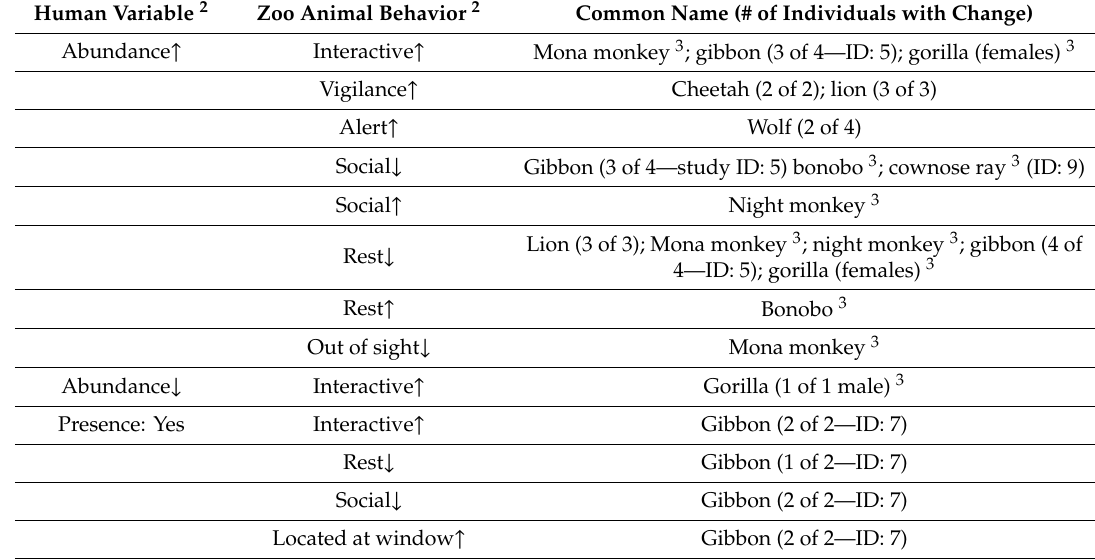
Table 4. Summary of behavioral changes associated with zoo visitors 1